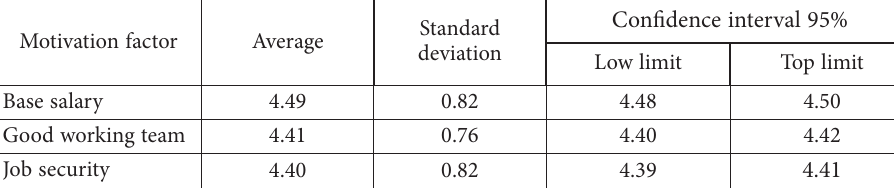
Table 3. Descriptive statistic and confidence interval 95%